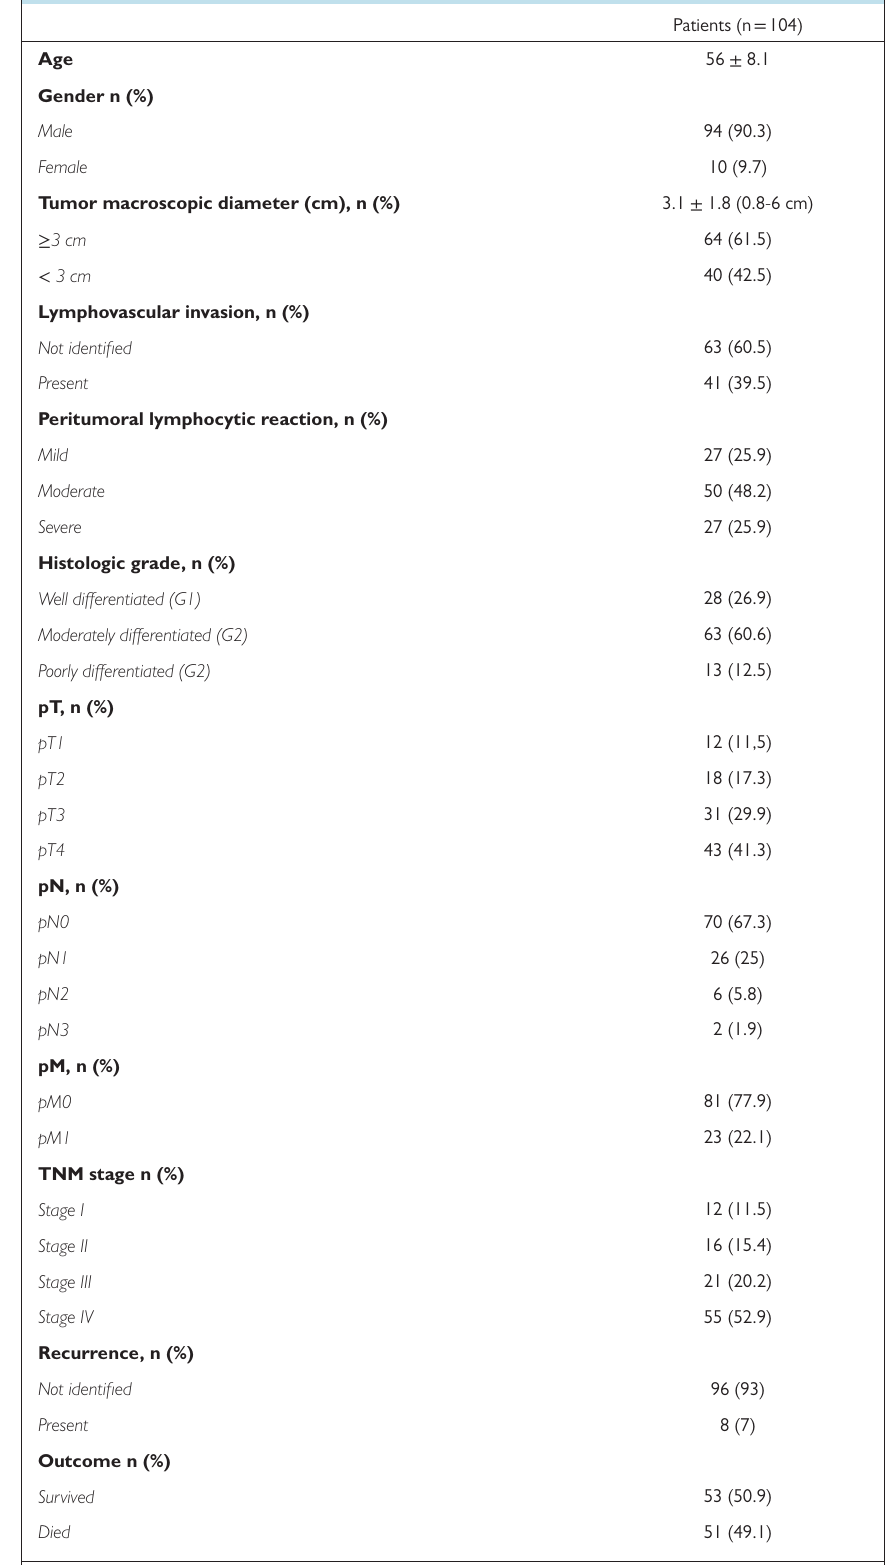
Table 1. Demographic and Histopathological Features of the Patients